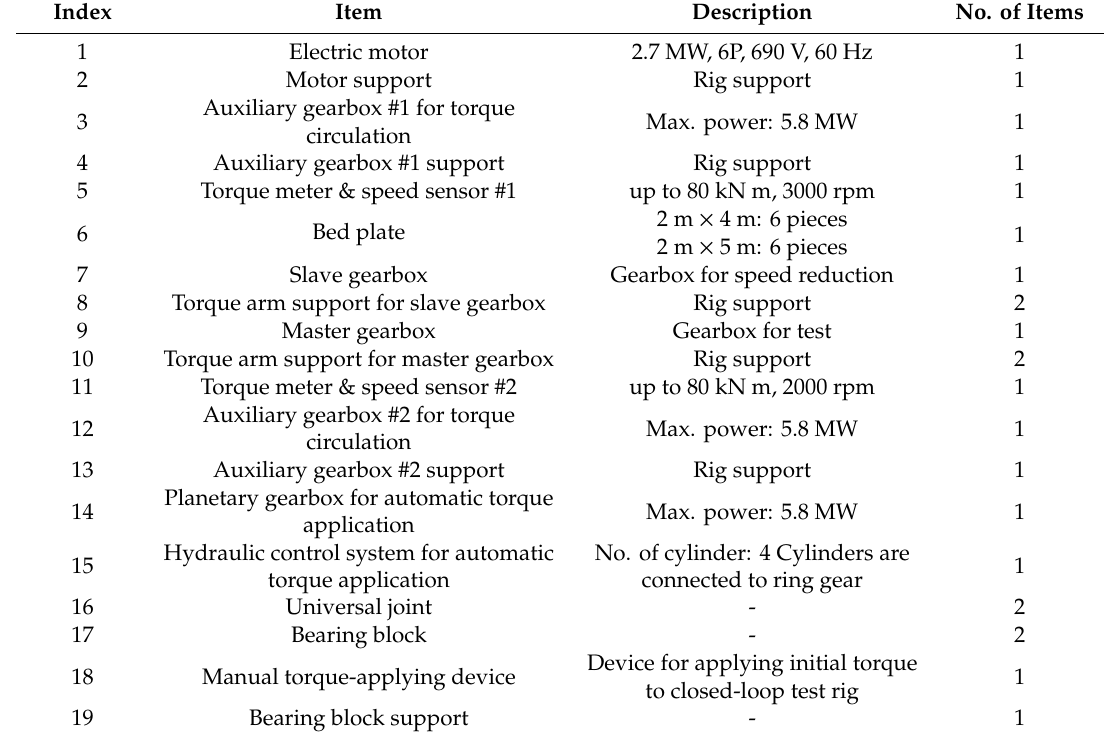
Table A1. List and description of test rig components.